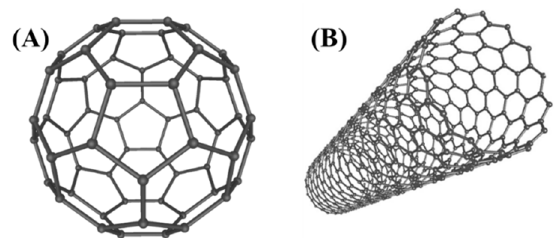
Figure 8 . Schematic of a C60 buckyball (Fullerene) ( A ) and carbon nanotube ( B ).